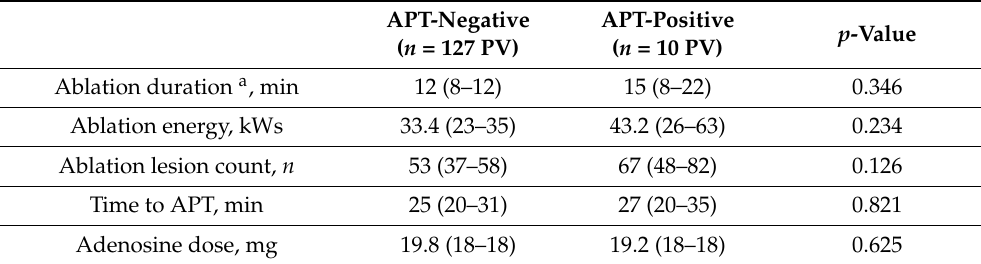
Table 5. Ablation data for HPSD.